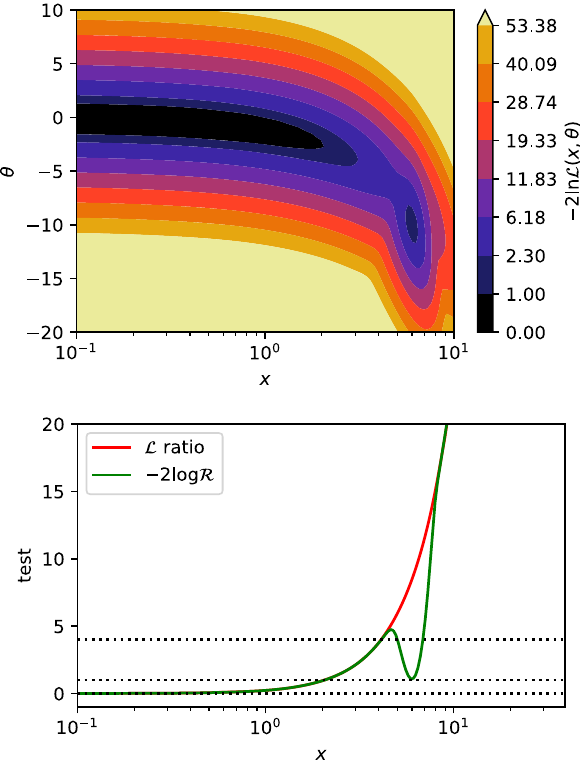
Fig. 1 Upper panel: Dependence of the likelihood in Eq. (10) on the parameters x and θ . Lower panel: Comparison of the results obtained with the likelihood ratio and the R methods when the likelihood in Eq. (10) is considered. The horizontal lines show the levels 0, 1, 4, respectively second peak of the posterior. For the same reason, the local minimum of − 2 ln R at x = 6